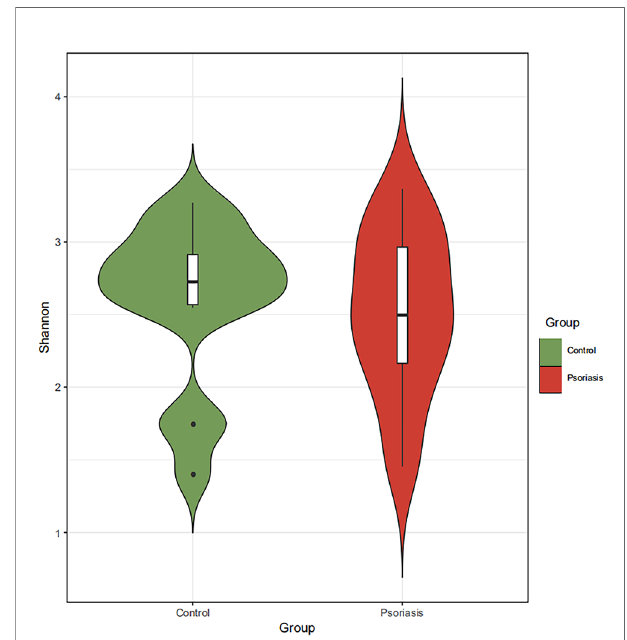
FIGURE 2 | a -Diversity based on Shannon indices displayed no signi fi cant differences in the intestinal microbiota between the two groups.